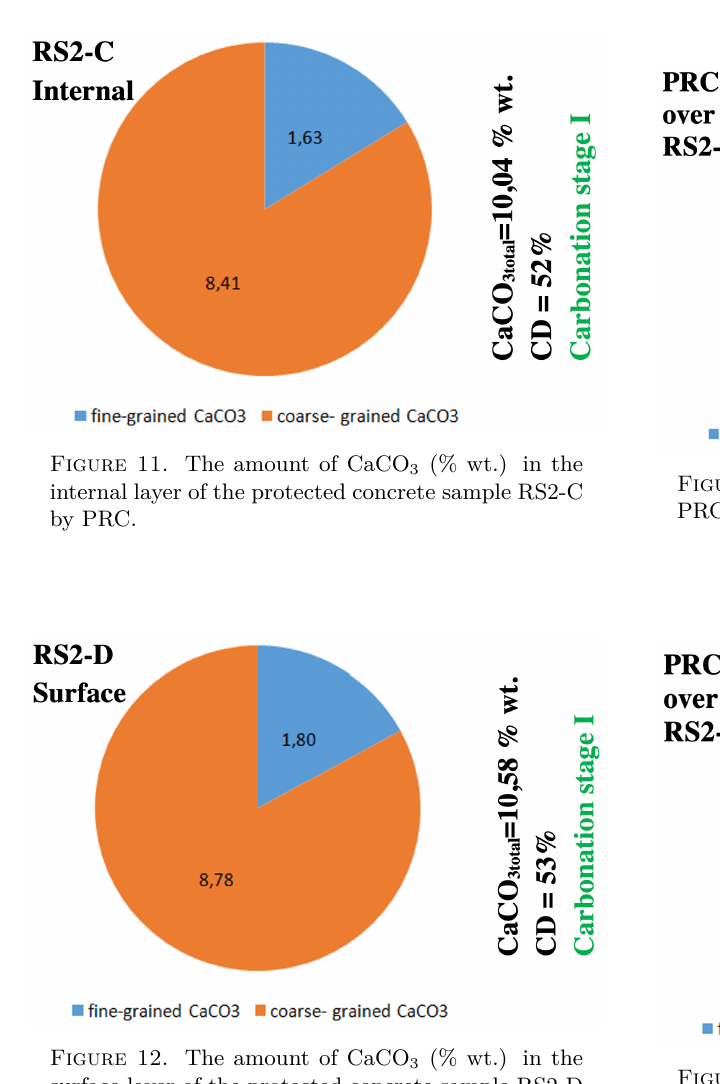
Figure 15. The amount of CaCO 3 (% wt.) in the PRC sample over